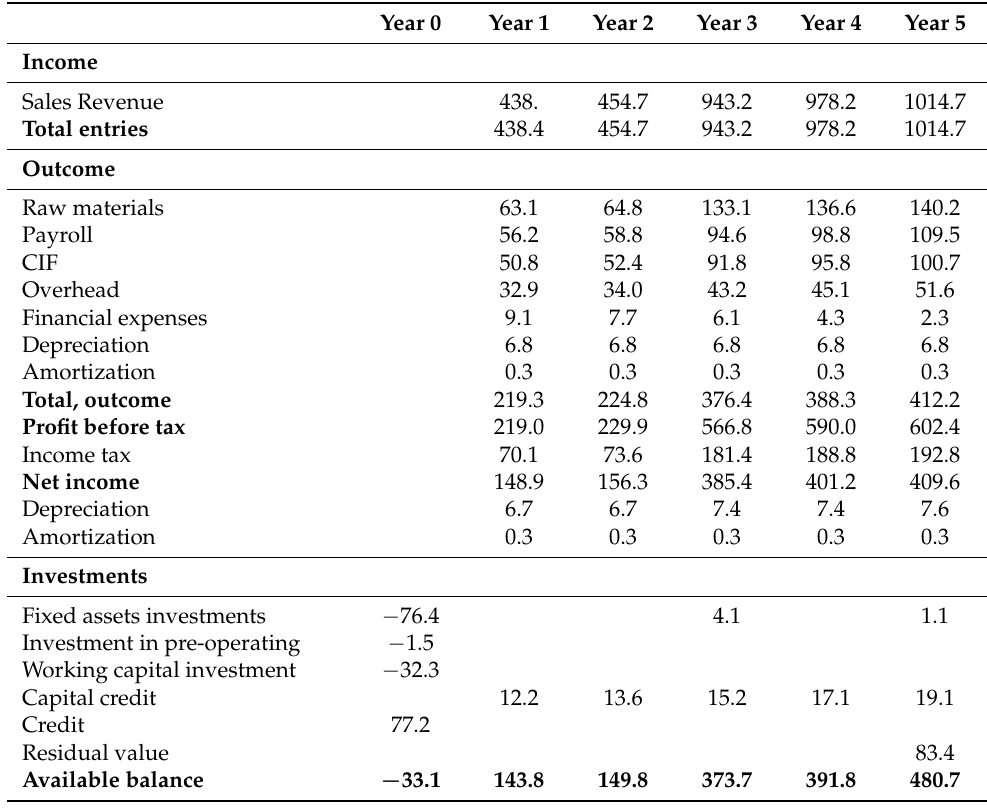
Table 4. Five-year projection cash flow for a plastic sand cobbles start-up manufacturing company (in miles of